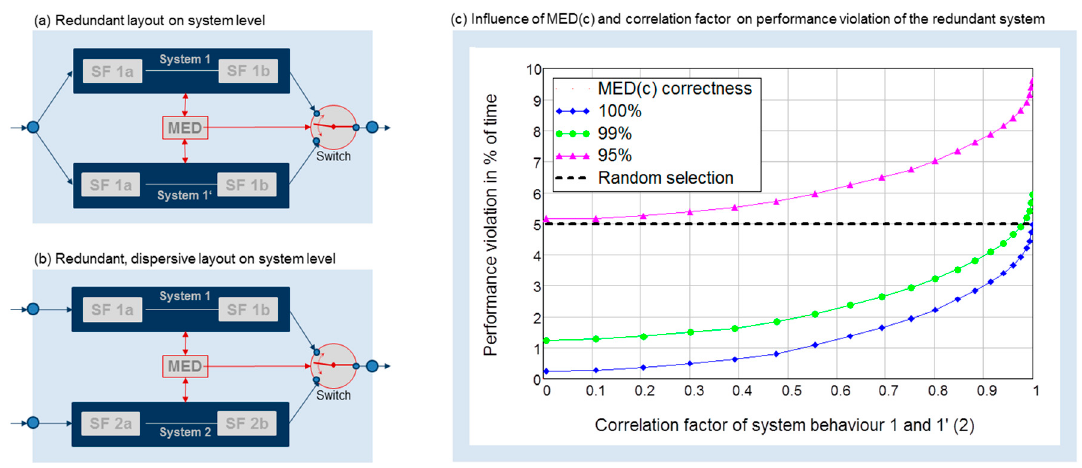
Figure 1. Redundant layouts of a system (consisting of two system functions SF a and SF b) with physical redundancy ( a ), as well as functional redundancy ( b ), and remaining performance violation ( c ), as a function of the correlation factor between the redundant system branches and correctness of MED function.